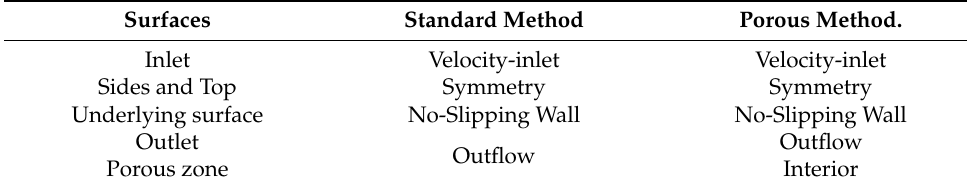
Figure 7. ( a ) Comparison of measurement data with the standard simulation results ( b ) Comparison of the measurement data with standard simulation, and porous simulation results. Table 1. Boundary setting details of standard method and porous